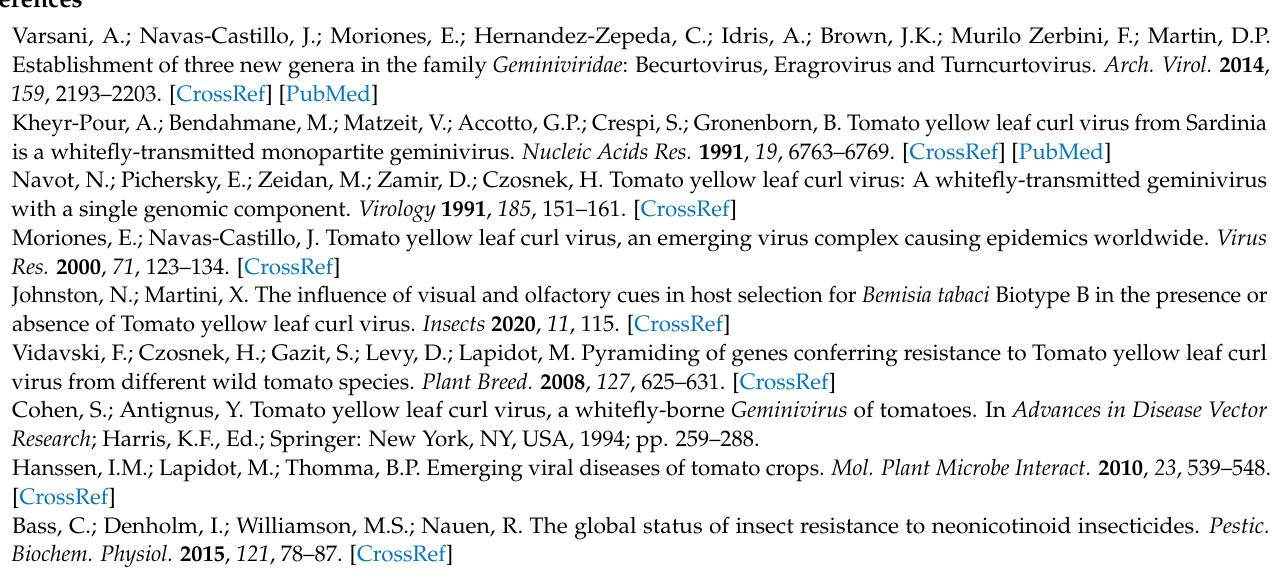
Figure S2: Pearson correlation analysis of the FPKM values of leaf samples in tomato under TYLCV infection. Figure S3: The Kyoto encyclopedia of genes and genomes (KEGG) map of the signal trans- duction of different plant hormones. Table S1: Genes and primers for qRT-PCR. Table S2: Summary of aligned and mapped reads. Table S3: Differentially expressed genes in Moneymaker (MK) and CLN2777A (T2). Table S4: GO and KEGG pathway annotation of DEGs. Table S5: Expressed genes for phytohormones biosynthesis and signaling